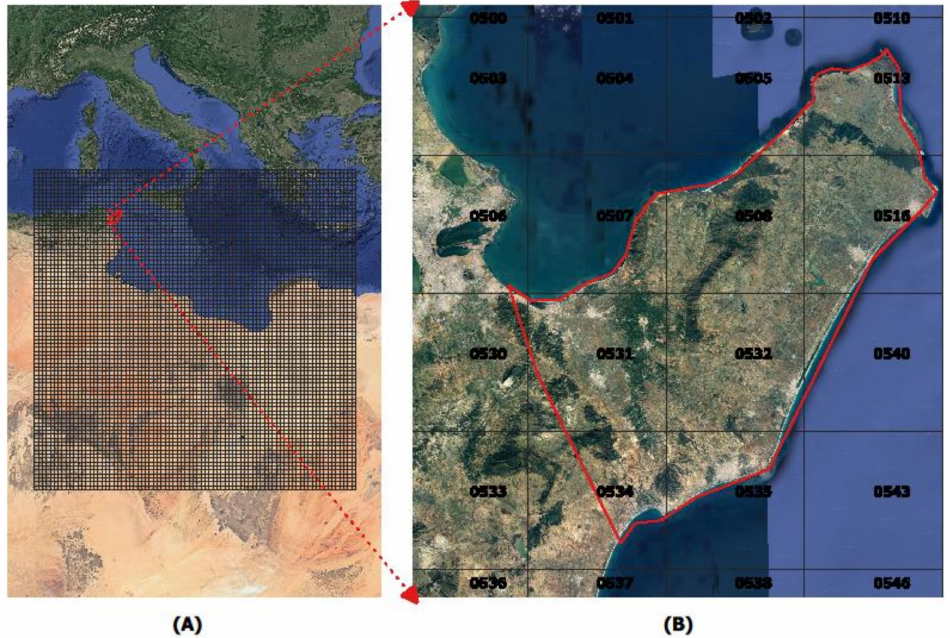
Figure 4. Tuplekeys that cover the Cap Bon region for the selected storage level of detail (LOD 4): ( A ) the selected LOD 4 covering all the region of interest ROI; and ( B ) zoom on the LOD 4 to the study area showing the 12